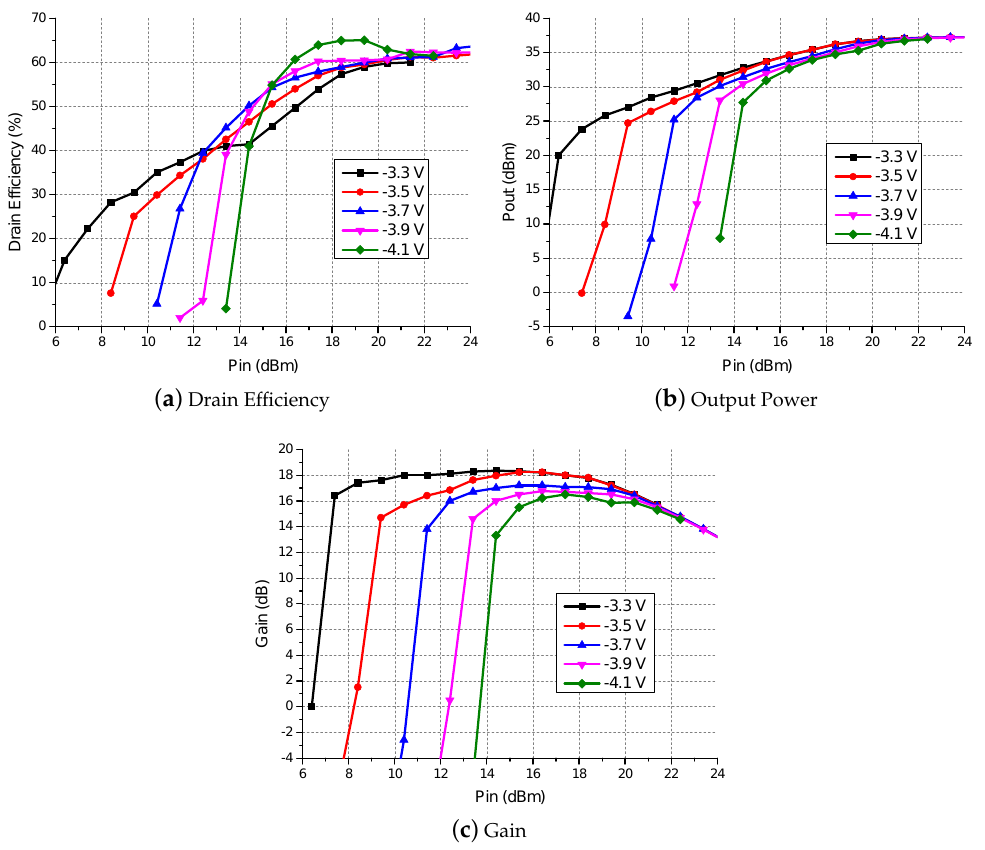
Figure 15. Measured performances of the designed class-C-F PA with respect to different gate